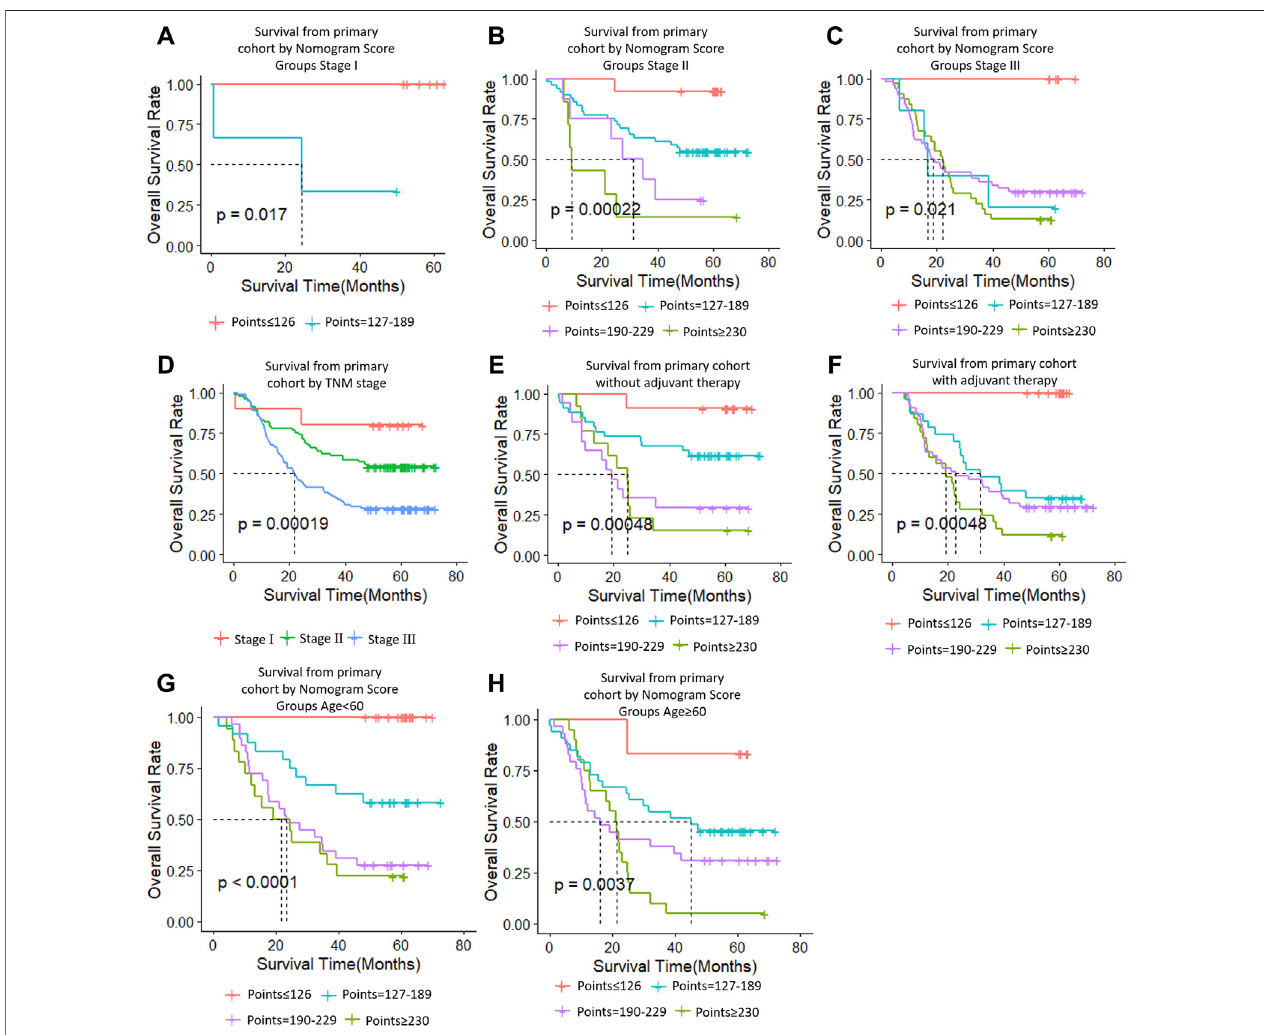
FIGURE7| Riskgroup strati fi cation withineach TNMstage (stages, (A – C) ; (D) ,all patients), groupaccording towhether receiveadjuvant therapy (E,F) and group by age (G,H) .